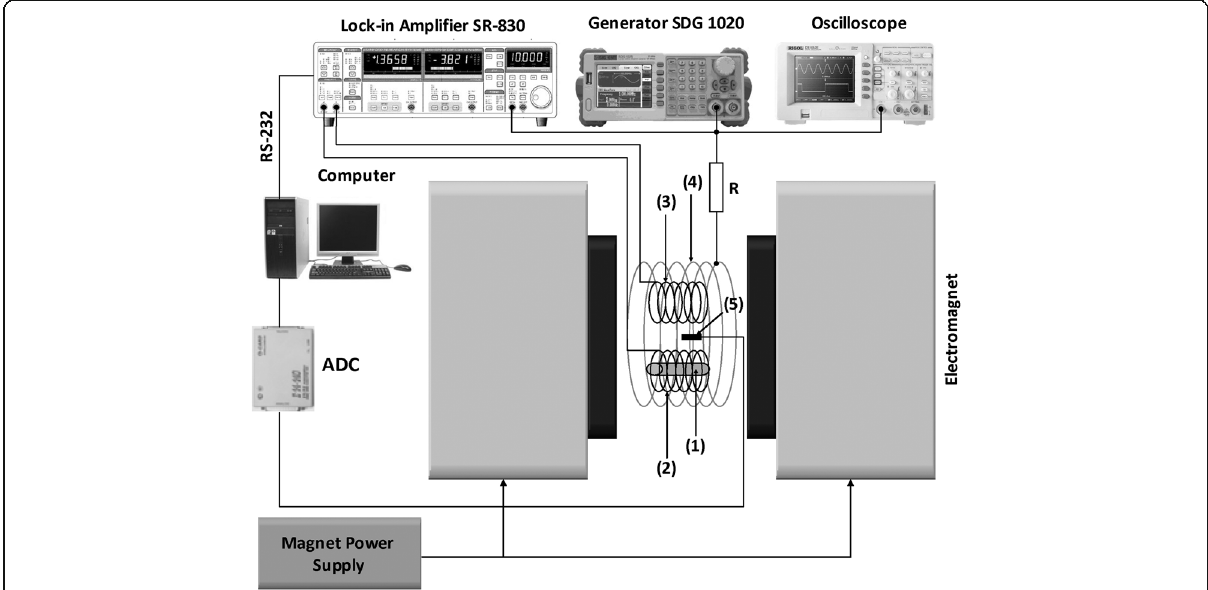
Fig. 2 Setup for measure AC susceptibility. 1 — superparamagnetic nanoparticles, 2 — pick-up coil, 3 — compensation coil, 4 — excitation coil, 5 — Hall